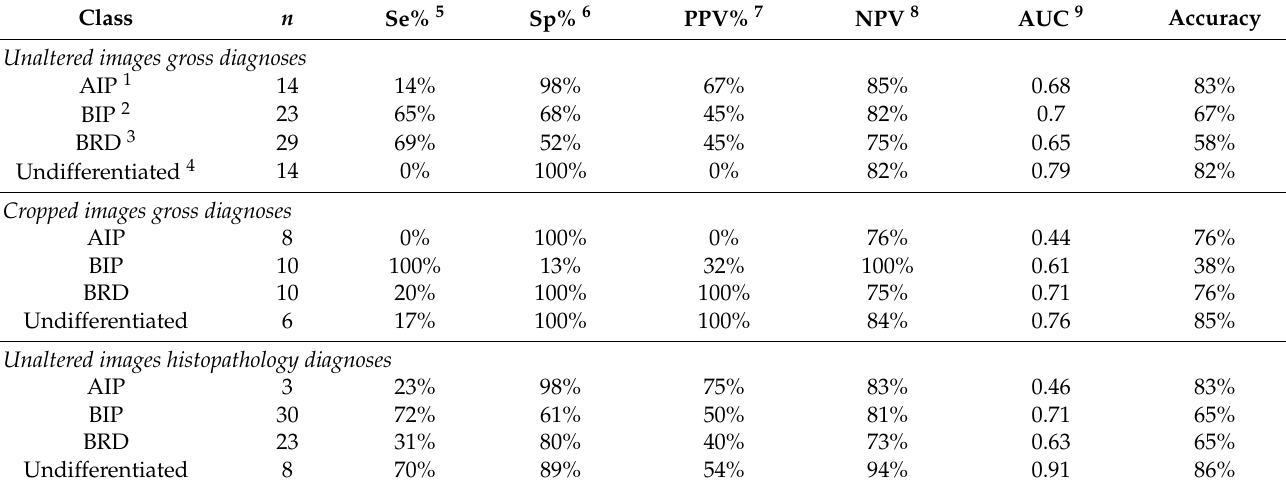
Table 2. Performance estimates resulting from the image classification models using the automated ML feature of Microsoft Azure for right lateral lung cattle images using the following data sets: unaltered images and their respective gross diagnoses, unaltered images and their respective his ‐ tology diagnoses, cropped images and their respective gross diagnoses, and cropped images and their histology diagnosis.